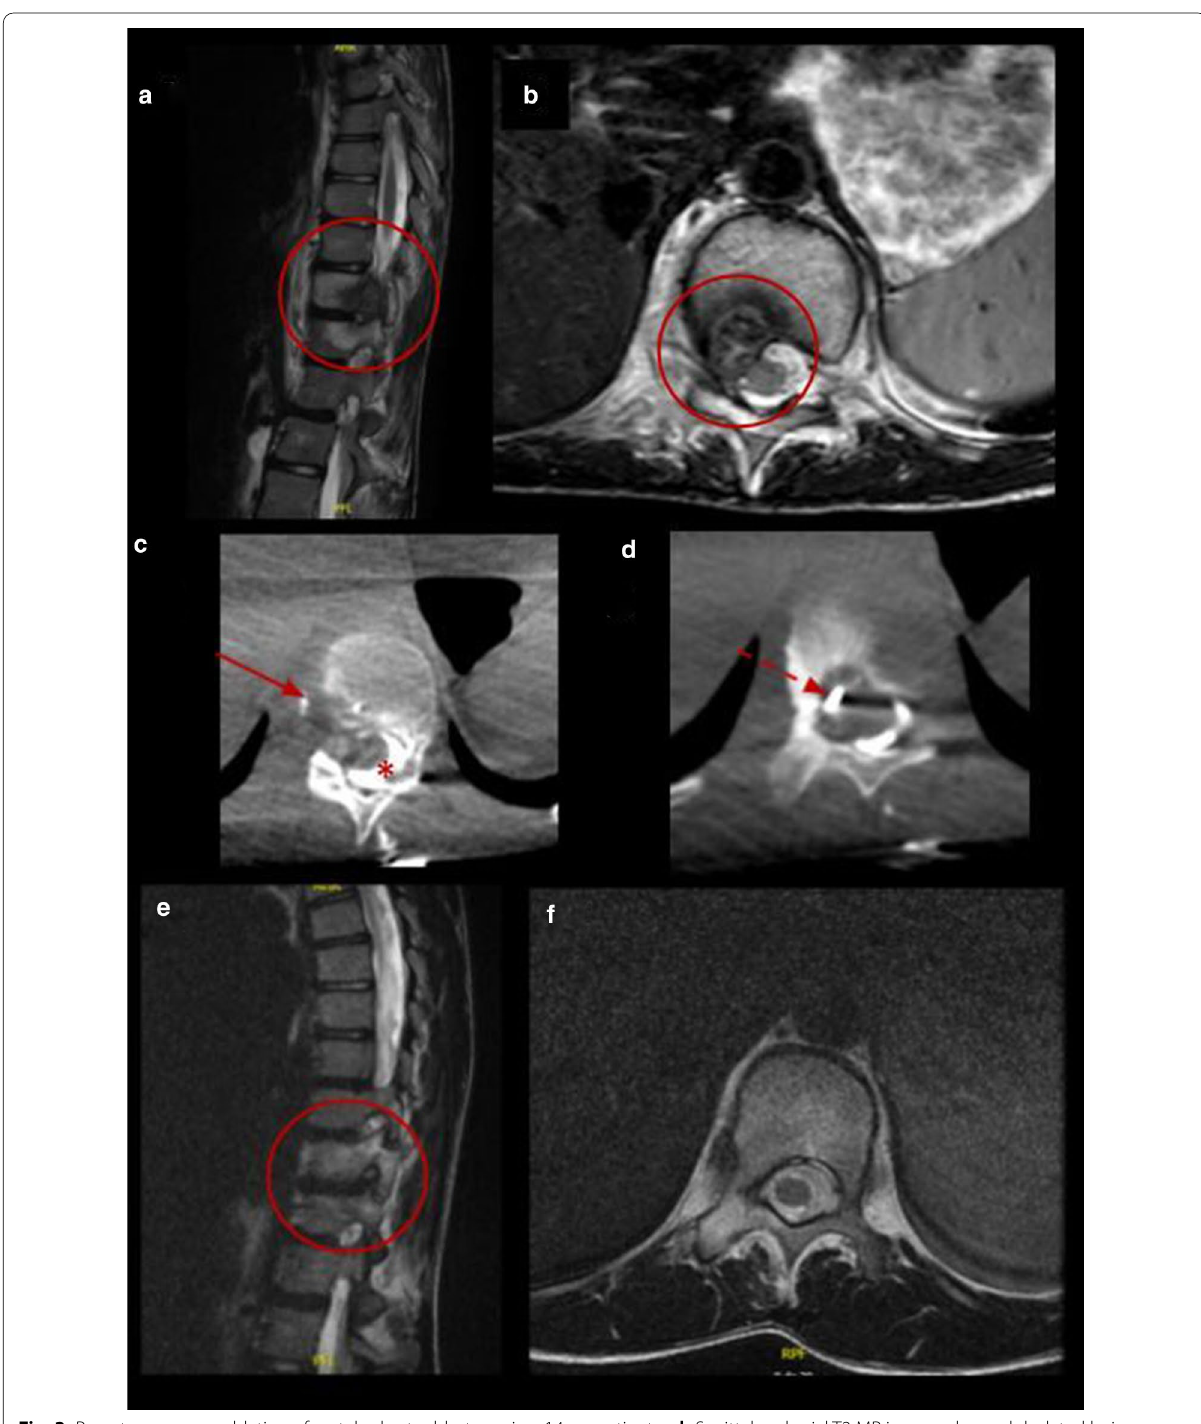
Fig. 3 Percutaneous cryoablation of vertebral osteoblastoma in a 14‑y.o patient. a , b Sagittal and axial T2 MR images show a lobulated lesion located in the posterior aspect of the body of the 11th thoracic vertebra (red circle). c , d Cryoablation of OB (arrows). Cone beam CT axial reconstruction of the cryoprobe and epidural hydrodissection (asterisk). e , f Follow‑up MRI 12 months after procedure with complete resolution of the lesion (red